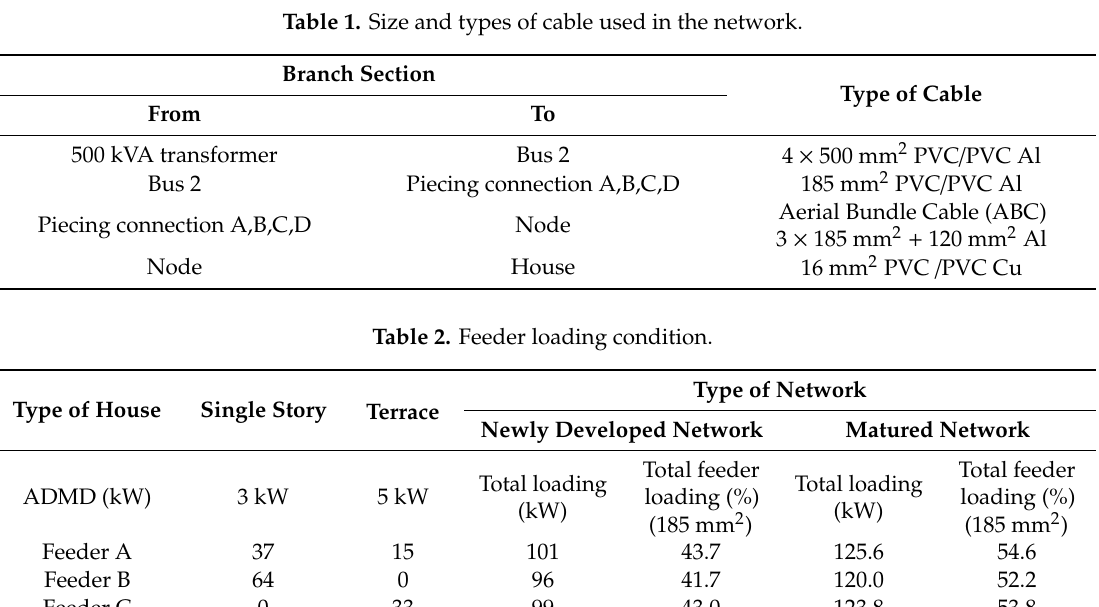
Figure 1. Single line diagram of residential LV distribution networks at Taman Impian Putra (BESS, battery energy storage system).